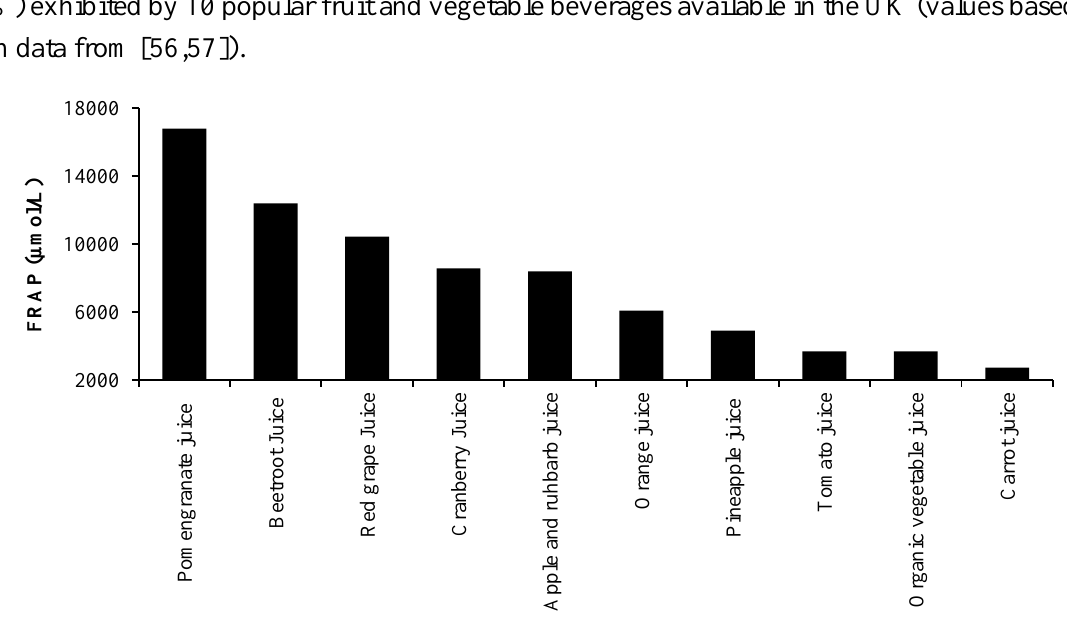
Figure 3. The free radical antioxidant power (FRAP) of 10 commercially available fruit and vegetable beverages post a simulated in vitro model of human digestion (values based on data from